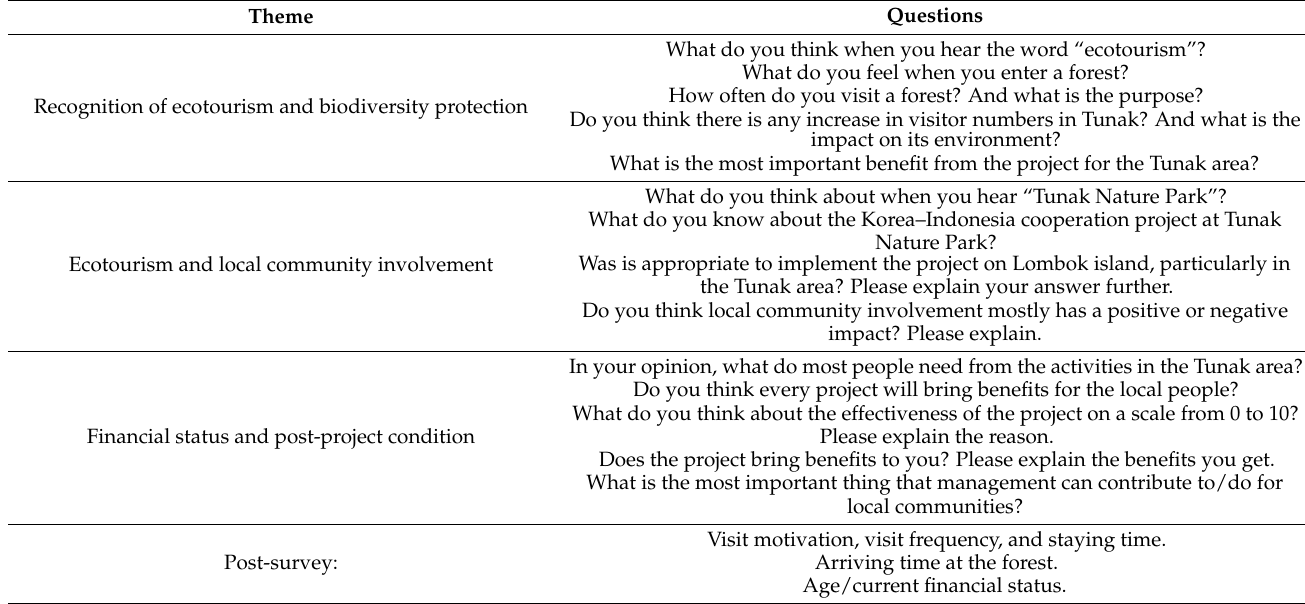
Table 2. Survey Interview Themes and Questions in